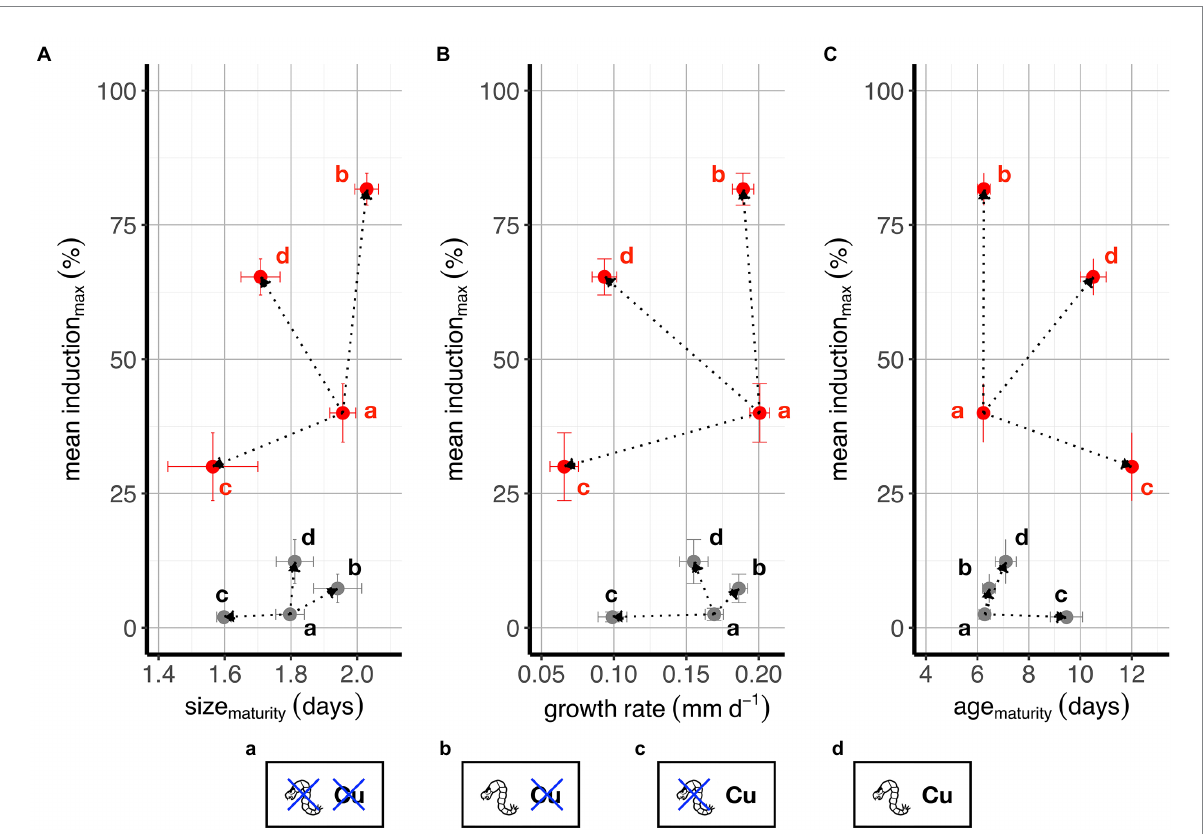
FIGURE 7 Clone type specific responses in key life history traits. Plots contrast mean morphological induction vs. observed responses in key life history traits: size at maturity (A) , somatic growth rate (B) , and age at maturity (C) . Black points: low responders; red points: high responders. Error bars indicate standard errors of mean values. Note: graphs show responses at extreme points in the response surface, i.e., control conditions (i.e., no predator cue and no copper) (a), high predation cue concentration & no copper (b), high copper concentration & no predation cues (c), and high predation cue concentration & high copper concentrations